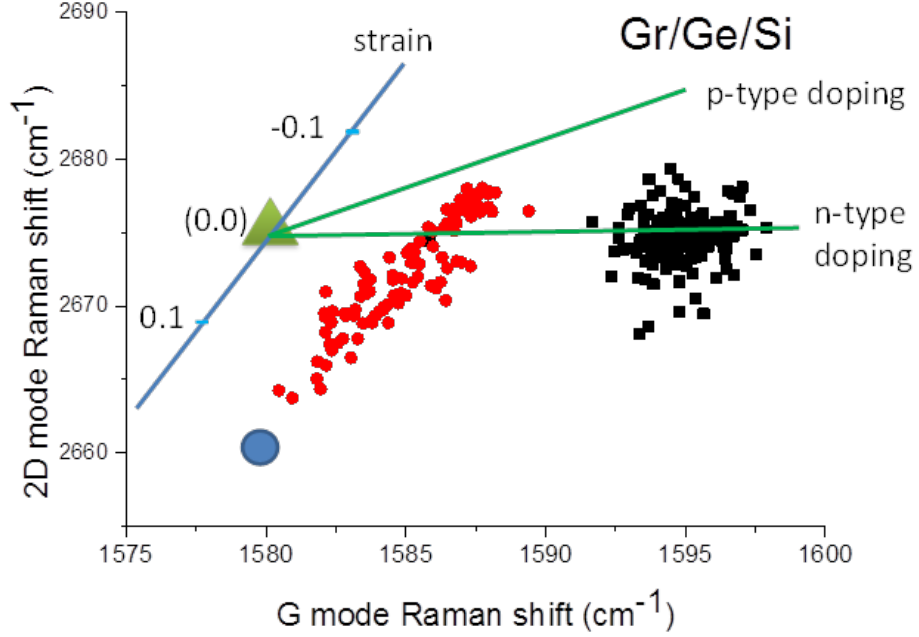
Figure 11. Plot of the position of the 2D band in relation to position of the G band for Gr/Ge(001)/Si(001) for virgin and for sample after 150 h of water vapor treatment. The black points represent plot before water vapor treatment of sample. Red points correspond to results on the blister after the treatment. The green triangle (0,0) represents the point of no-doped (<10 12 cm − 2 ) and no-strain graphene. The blue line represents no-doped graphene with varying values of strain (slope 2.2). The green lines represent no-strain graphene width with varying density of doping (n-type or p-type) [24]. The blue circle represents the experimental point on a blister where maximal enhancement of the Raman signal was observed.